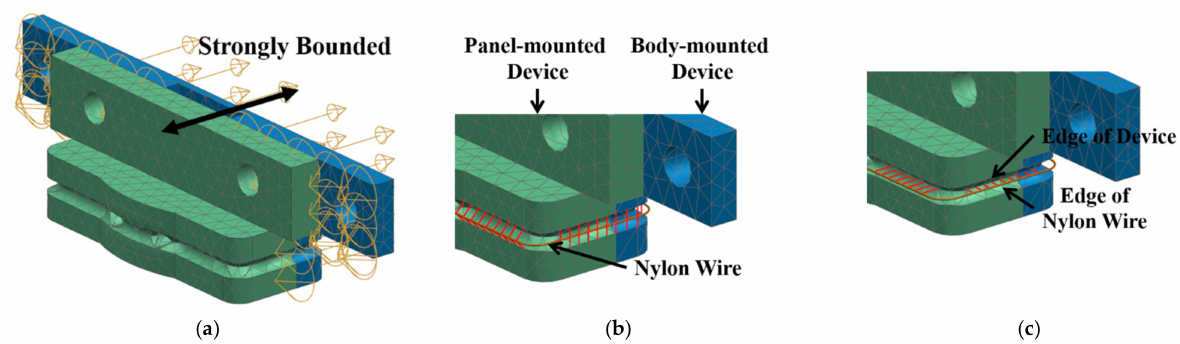
Figure 19. Three types of nylon wire tightening in the HRM of the Pumbaa: ( a ) Strongly bounded; ( b ) Nylon wire connected to edge of device; ( c ) Edge of nylon wire connected to edge of device.